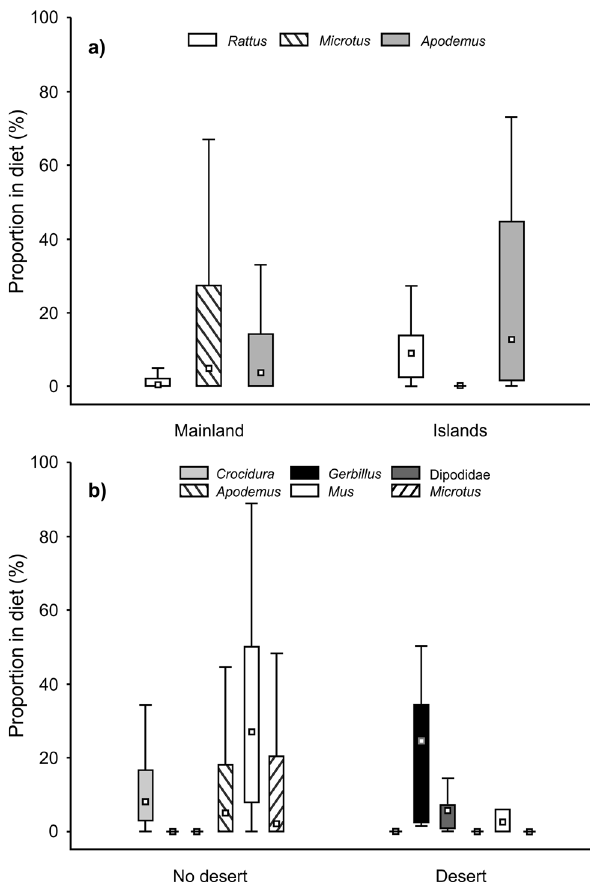
Figure 6. Proportions of selected mammalian prey at ( a ) continental (i.e. mainland) and island localities and ( b ) localities with presence of desert/other habitats. Squares—medians, boxes—25–75% of data, whiskers—non- outlier